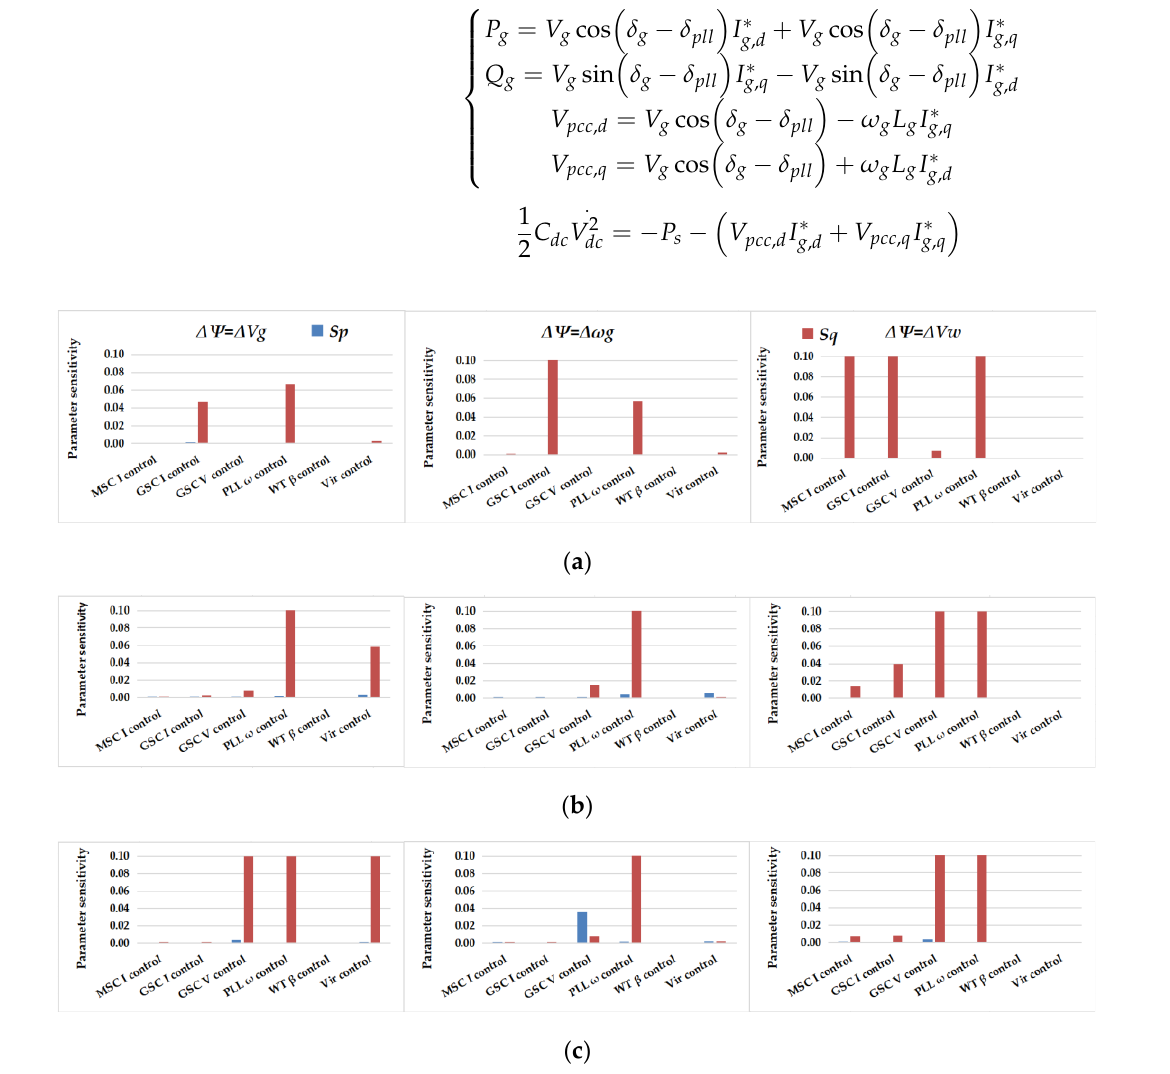
Figure 6. D-PMSG parameter sensitivity: ( a ) parameter sensitivity at 1 ms; ( b ) parameter sensitivity at 10 ms; ( c ) parameter sensitivity at 100 ms.